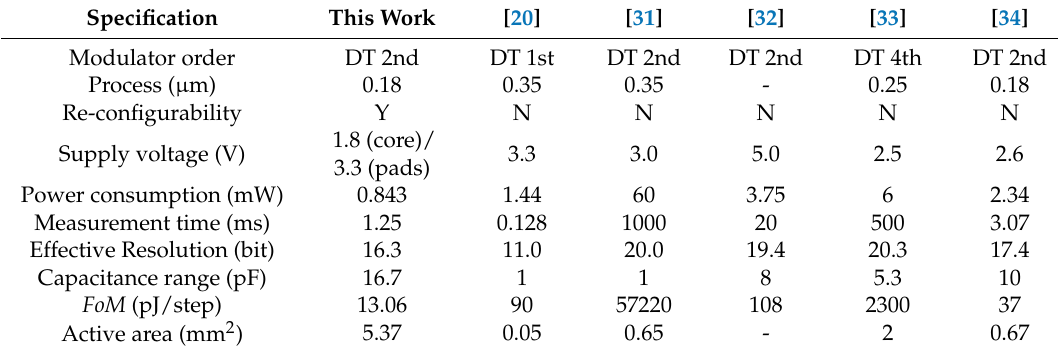
Table 1. Performance summary and